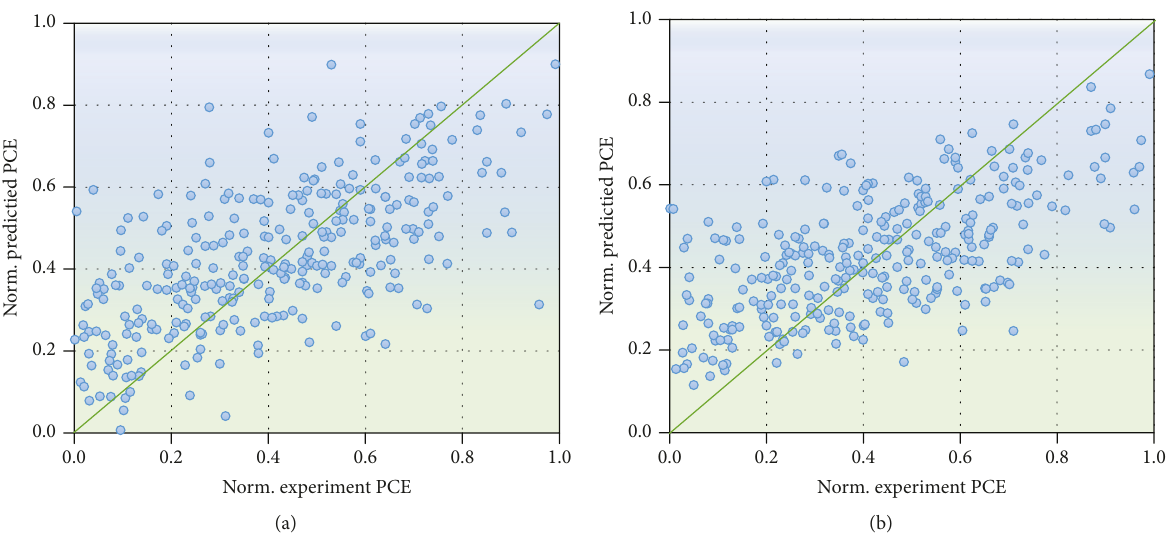
Figure 3: (a) The predictive result of the SVM model; the radius of the Morgan fi ngerprint was fi ve. (b) The predictive result of the RF model using the same split dataset.